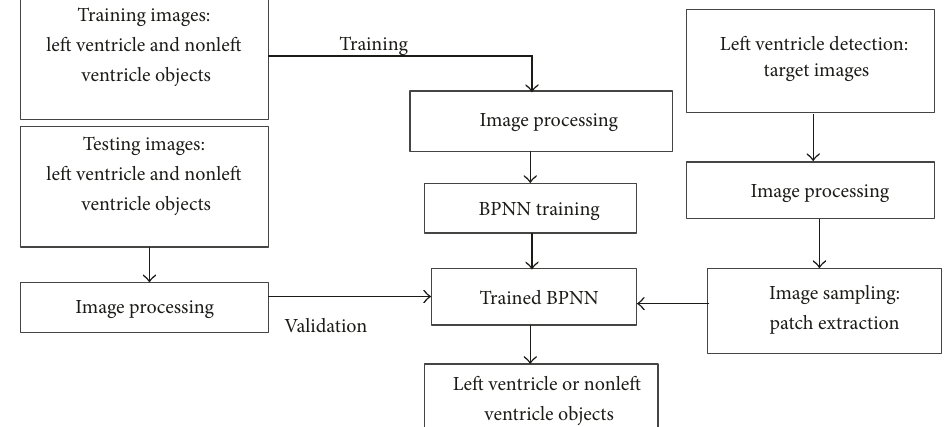
Figure 1: Flowchart for developed system.